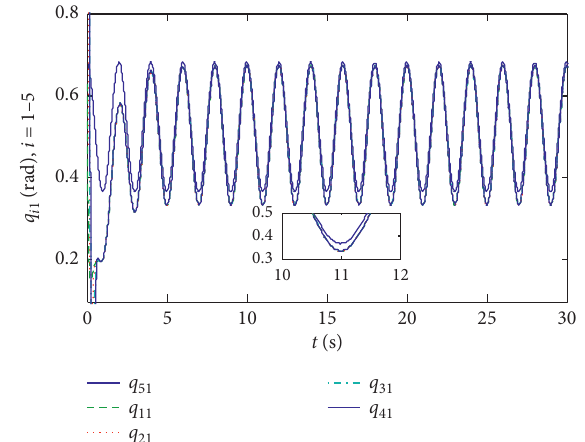
Figure 15: The generalized coordinates q